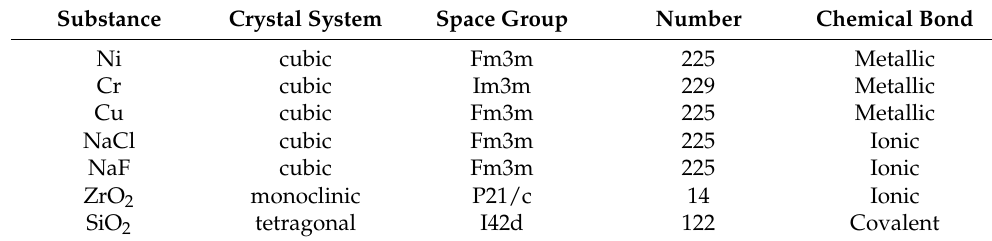
Table 1. Structural information used for the DFT calculations.